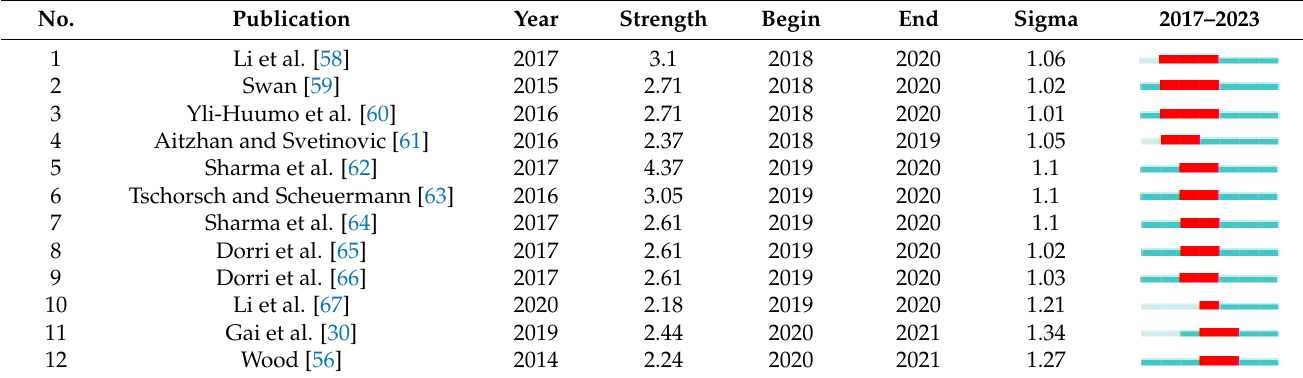
Table 8. Top 12 references with the strongest citation bursts.